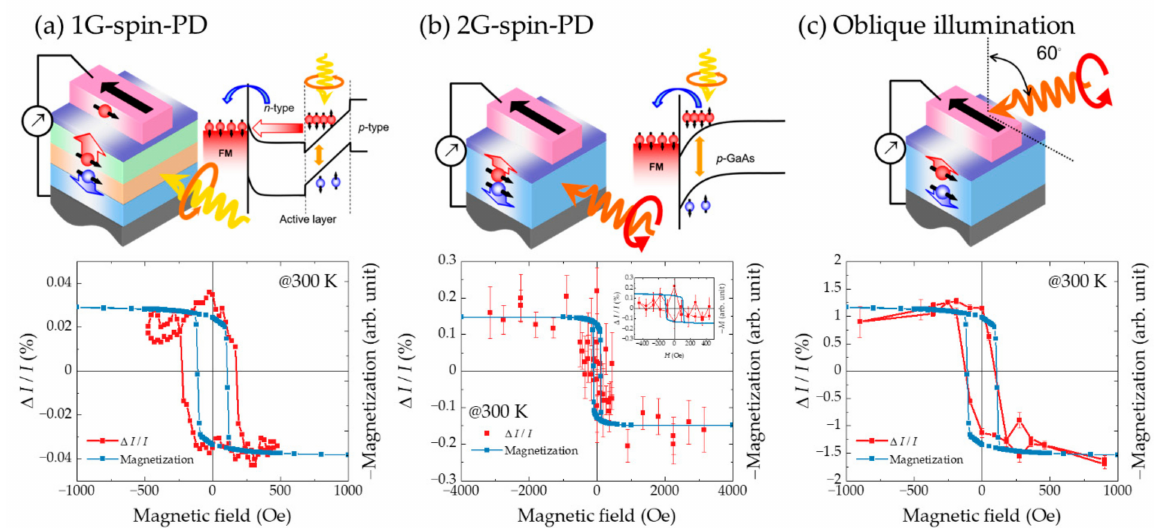
Figure 7. Schematic illustration of the device and experimental results of CPL detection for ( a ) a 1G-spin-PD with side illumination [100] and 2G-spin-PDs with ( b ) side illumination and (c) oblique illumination at 60 ◦ [101]. ( a ) and ( b ) also include schematic band diagrams in the upper right. The lower panels show the magnetic field dependence of the obtained photocurrent at RT and the electrode magnetization at 300 K. Reproduced with permission from